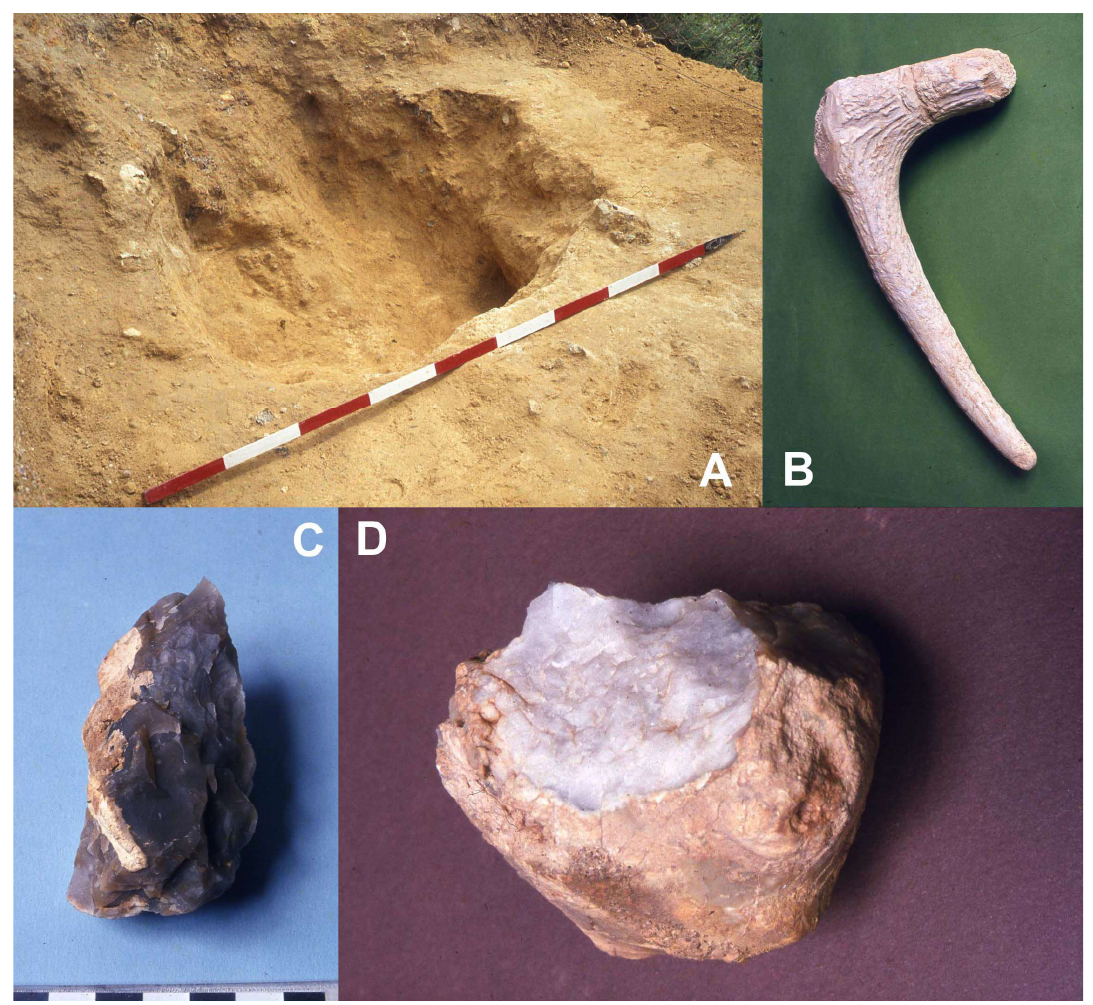
Figure 9. Budapest-Farkasrét site. A: extraction pit; B: antler tool; C: side-scraper; D: tested nodule. (Photo by M. Gábori, CAD by Z. Mester) Fig. 9. Site de Budapest-Farkasrét. A: fosse d’extraction; B: outil en bois de cerf; C: racloir; D: rognon testé. Cliché: M. Gábori, DAO: Z.